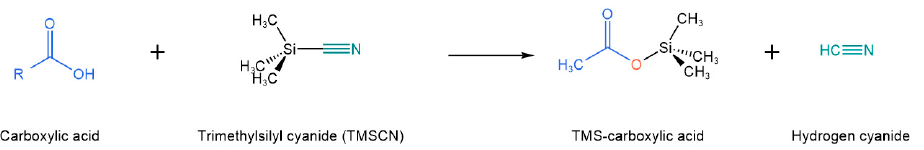
Figure 3. Example of silylation reaction used in the derivatization of odor-active carboxylic acids.